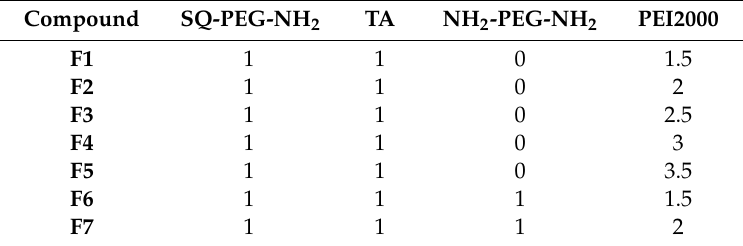
Table 1. Composition (in equivalents) of the synthetized dynamic combinatorial frameworks (DCFs) library.